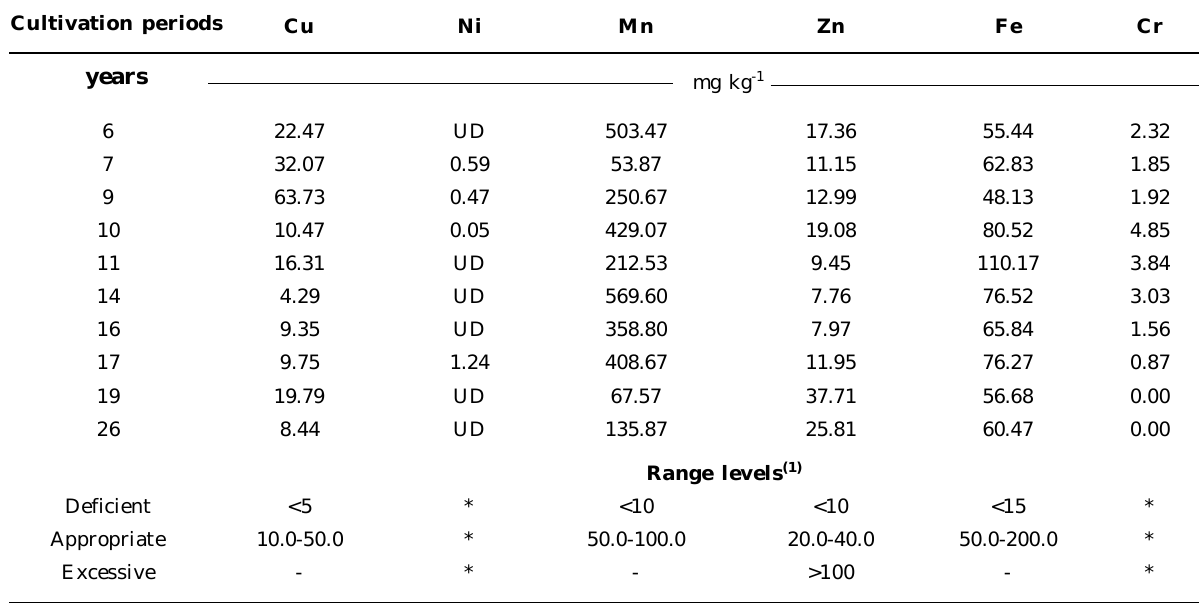
Table 2. Heavy metal contents in leaves of mango trees, grown in northeastern Brazil for different cultivation